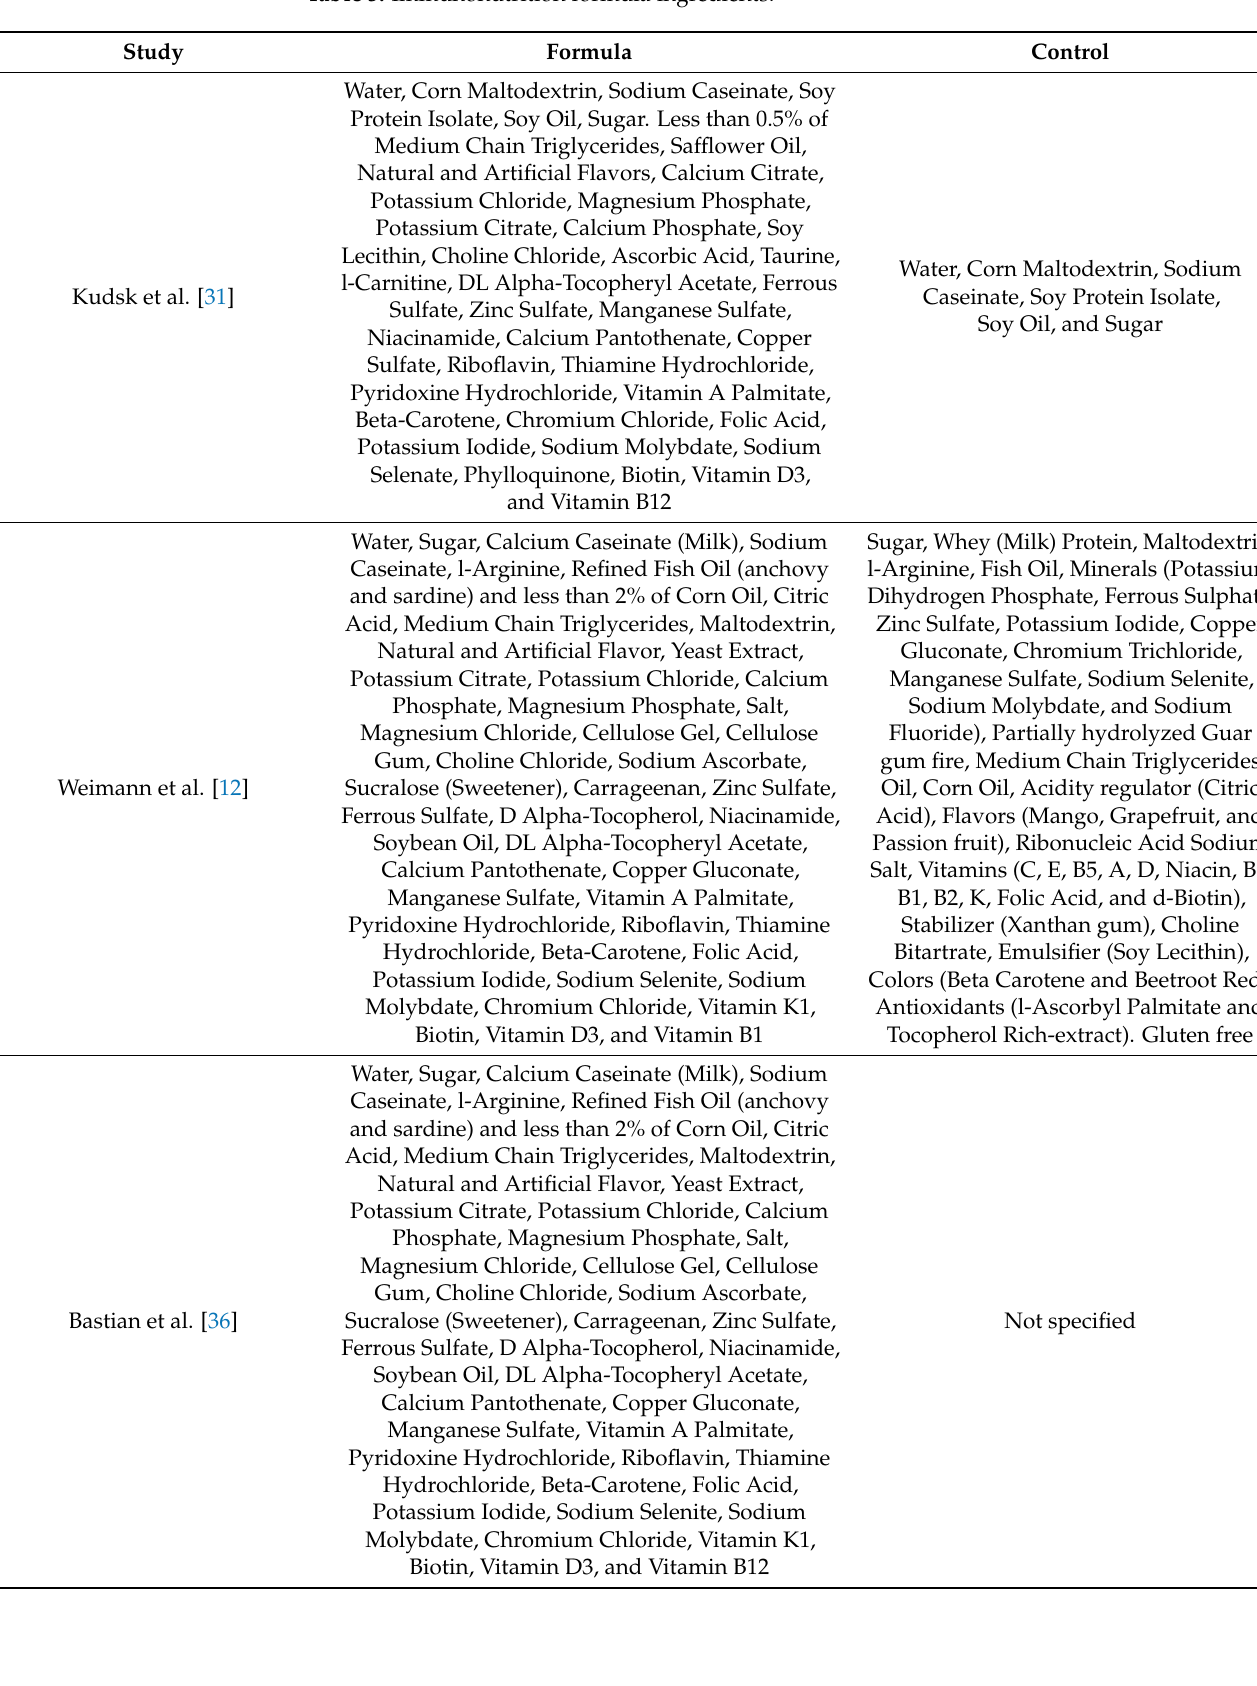
Table 3. Immunonutrition formula